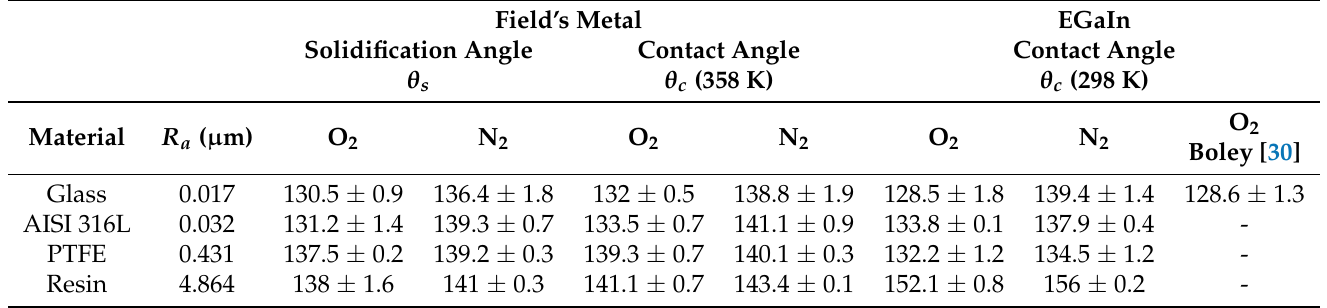
Table 5. Measurements of the contact angle θ c and the solidification angle θ s of Field’s metal and EGaIn over different substrates, in presence of O 2 and N 2